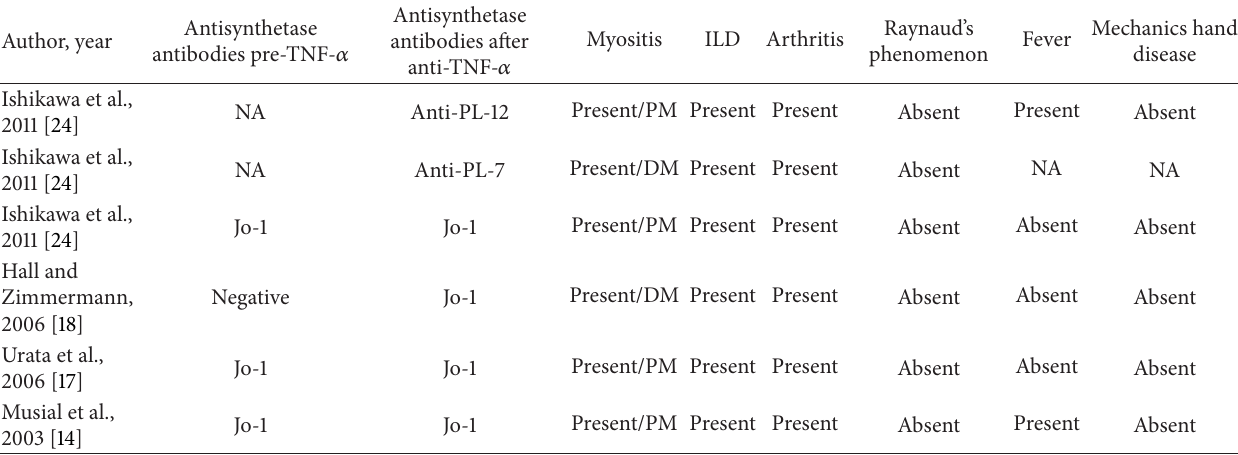
Table 2: Characteristics of patients reported regarding diagnostic parameters for antisynthetase